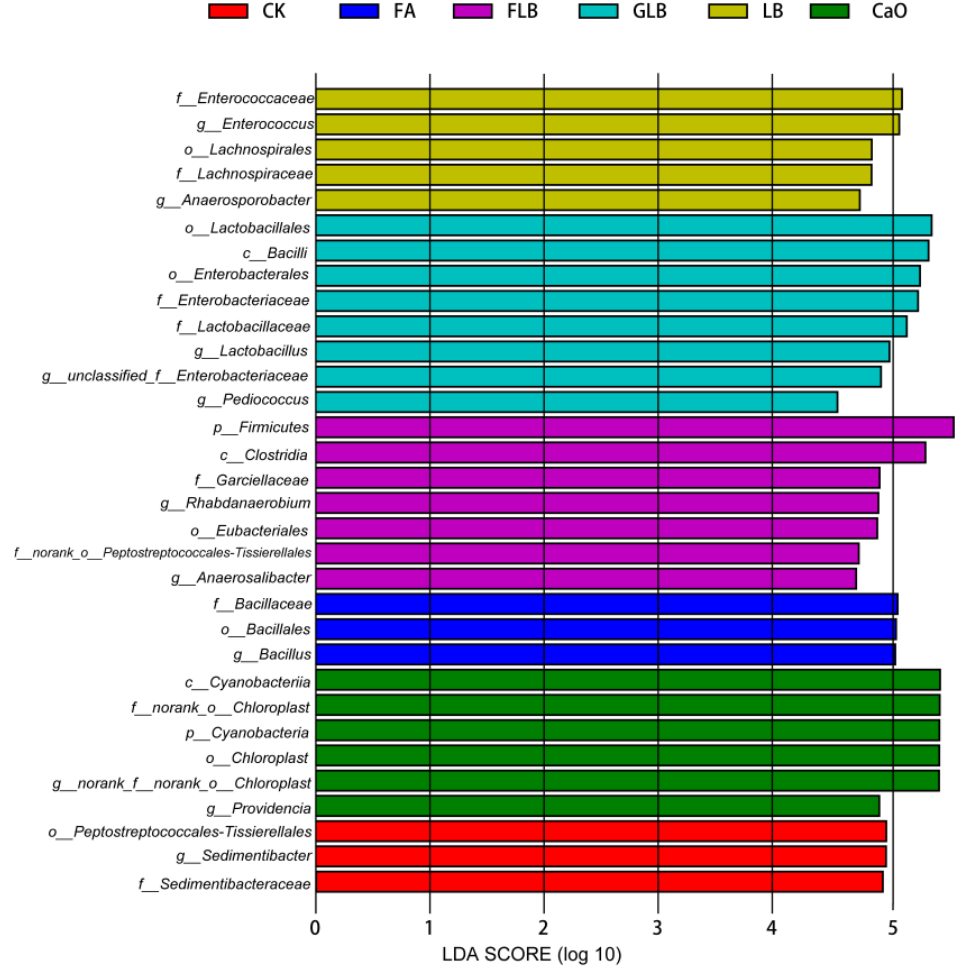
Figure 4. Bacterial communities and relative abundances at the genus level in alfalfa silage after 60 days of fermentation. CK, control, no additive; FA, 0.6% formic acid; CaO, 3% calcium oxide and 3% urea; LB, 1 × 10 6 cfu/g L. buchneri ; GLB, 2% glucose and 1 × 10 6 cfu/g L. buchneri ; FLB, 2% fucoidan and 1 × 10 6 cfu/g L. buchneri .